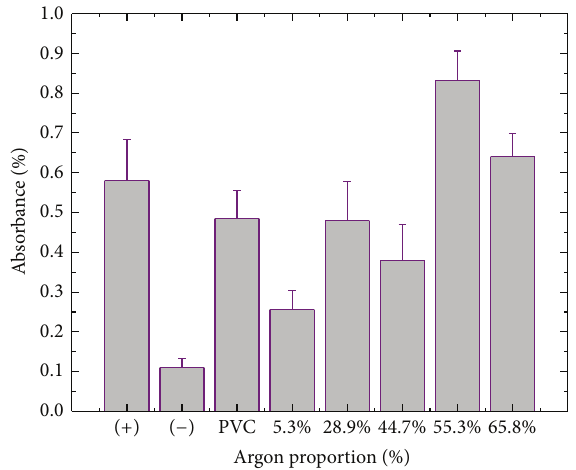
Figure 7: Absorbance of the MTT as an indicator of Vero cell adhesion on the bare and coated PVC samples. The films were deposited at various proportions of argon in the gas mixture. The absorbances of the positive and negative controls are also